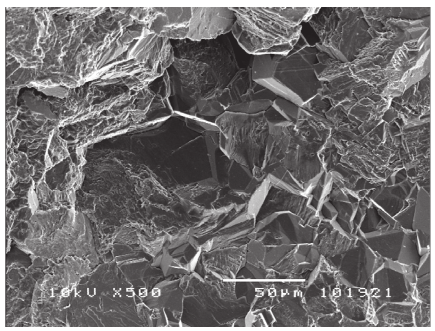
Figure 18: Marble cleavage plane, × 500.